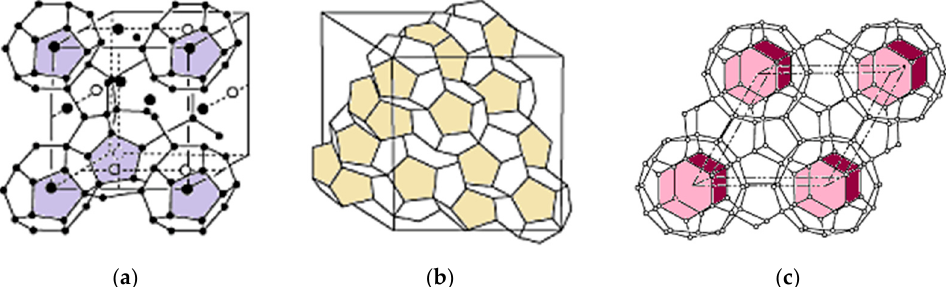
Figure 1. The three common gas hydrate structures with assembling of unit cells. ( a ) Structure I, ( b ) Structure II and ( c ) Structure sH